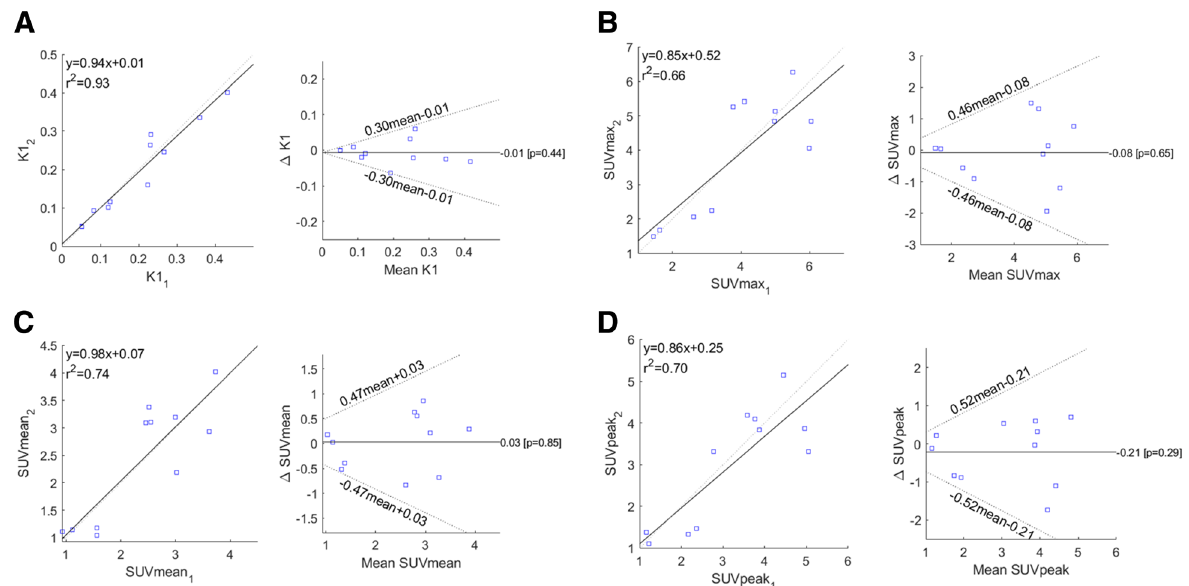
Fig. 2 Replicate measures are plotted against each other for K1 ( a ), SUVmax ( b ), SUVmean ( c ), and SUVpeak ( d ). Gray dashed line represents y = x , whereas the solid black line is the linear fit. Linear equation and Pearson ’ s r 2 are shown. Bland-Altman plots of back-transformed data for K1 ( a ), SUVmax ( b ), SUVmean ( c ), and SUVpeak ( d ). The black solid line is the mean difference between measurement 2 and 1. Black dotted lines are 95% upper and lower 95% limits of agreement (1.96 × sd on the log-transformed